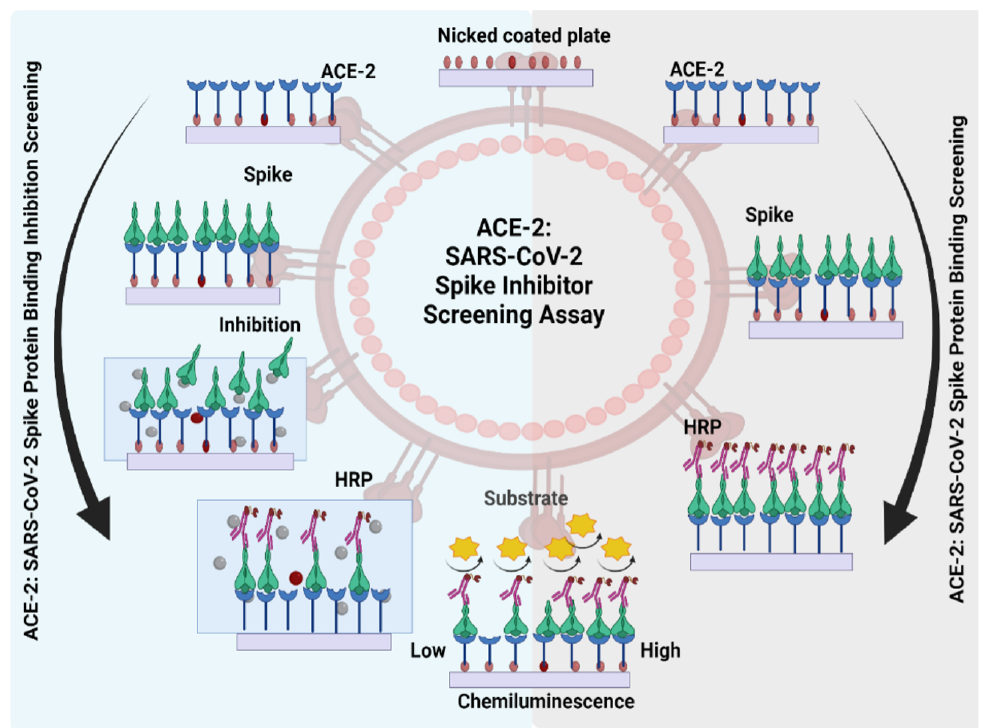
Figure A1. The schematic diagram indicates the binding between spike protein of the SARS-CoV2 and ACE2 protein on the cell membrane and how the inhibitor compounds work against this inhibition. ACE-2:SARS-CoV-2 spike protein binding screening (negative control): first, the immobilized ACE2 protein in a nickel-coated 96-well plate followed by enough spike protein added on top. In addition, the HRP-modified antibody is bound to the top of the protein, and then the catalyst substrates produce chemiluminescence. Seven molecules including N-Acetyllactosamine, N-acetyl-neuraminic acid, 3 α ,6 α -Mannopentaose, N-glycolylneuraminic acid, 2-Keto-3-deoxyoctonate ammonium salt, cytidine- 5-monophospho-Nacetylneuraminic acid sodium salt, and darunavir were tested as inhibitors for the inhibition of binding between ACE2 and spike protein of the SARS-CoV2 using BPS bioscience ACE-2:SARS-CoV2 spike inhibitor screening ELISA assay